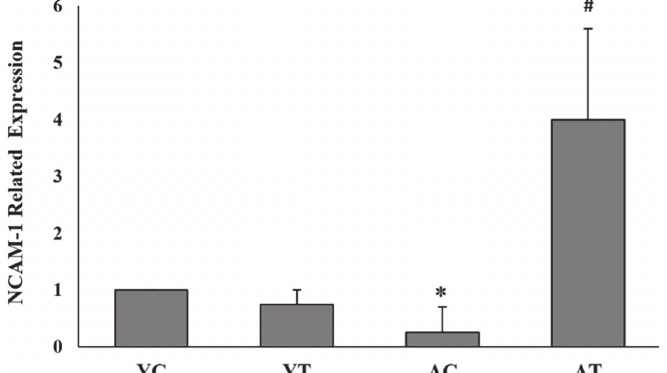
FIGURE 3 Related Expression mRNA NCAM-1. YC: Young Control; YT: Young Training; AC: Aged Control; AT: Aged Training; *: Significant Difference to YC. #: Significant Difference to